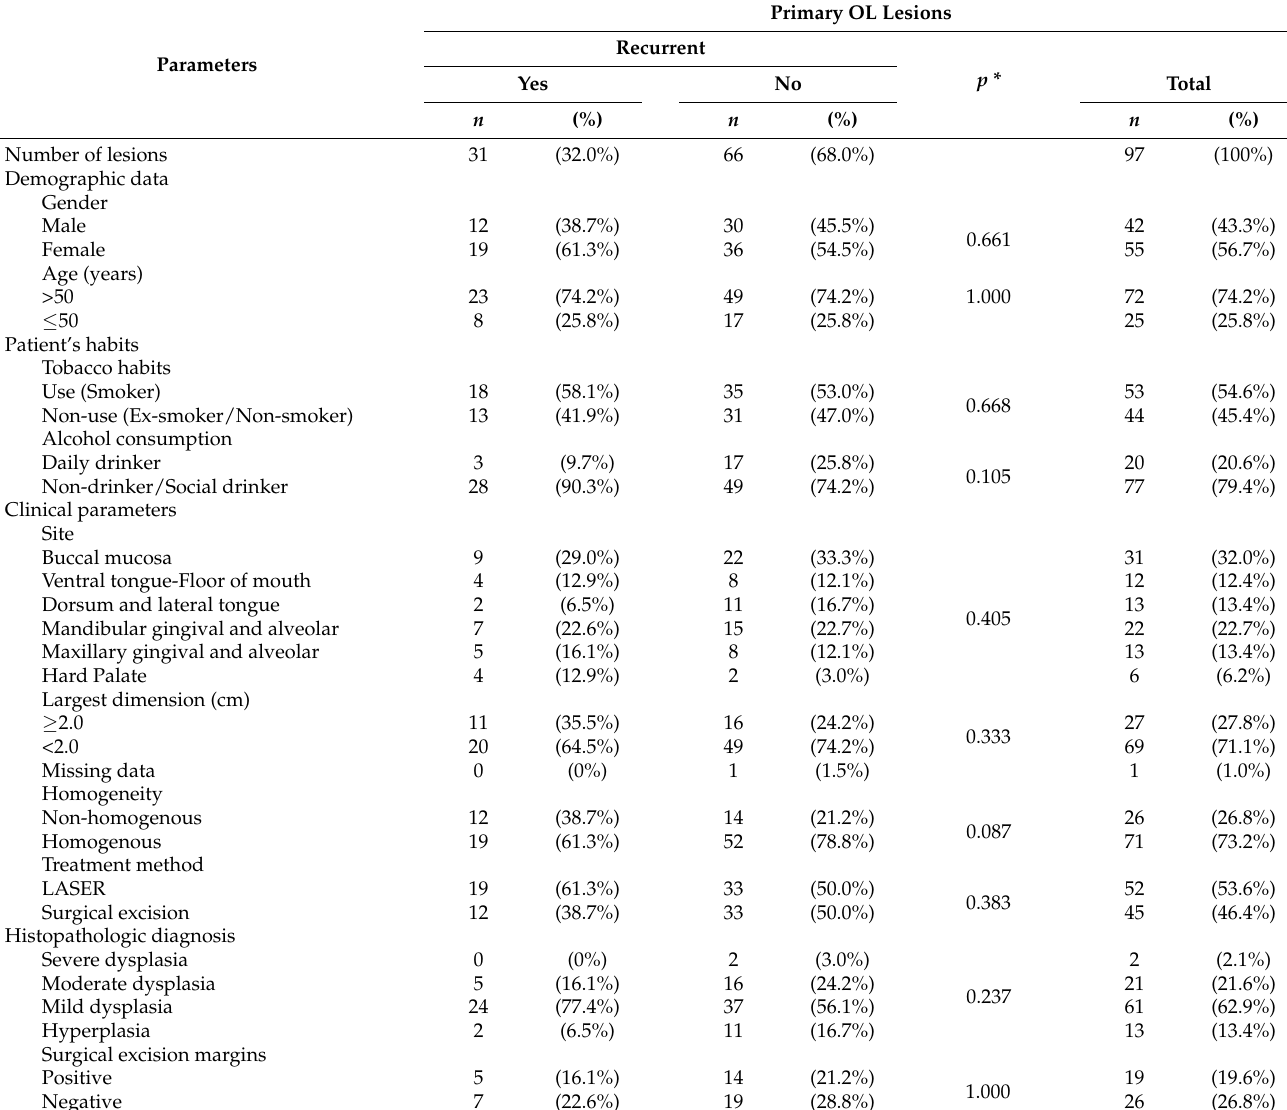
Table 2. Frequency distribution and comparison of demographics, tobacco and alcohol habits, and clinical and histopatho- logic parameters between recurrent and non-recurrent primary oral leukoplakia (OL)